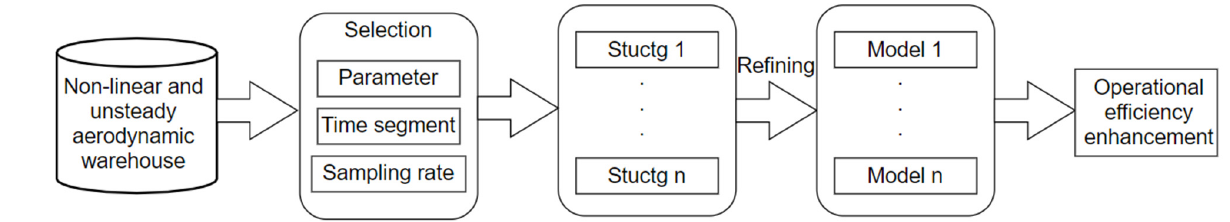
Figure 2. Flowchart for the development of nonlinear and unsteady aerodynamic models.